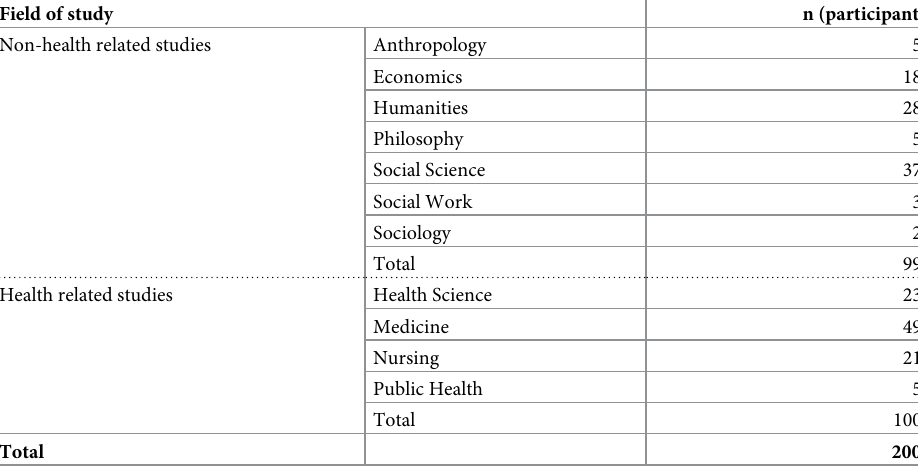
Table 2. Frequency table of field of